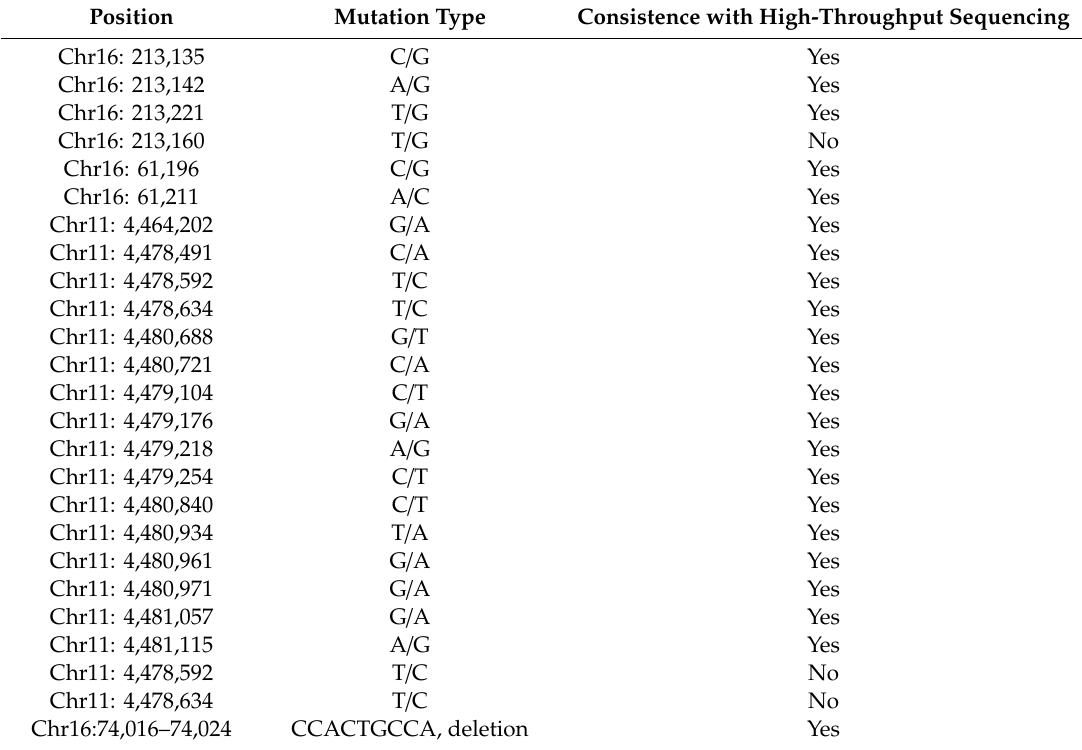
Table 5. Validations of SNPs and Indels by Sanger sequencing.